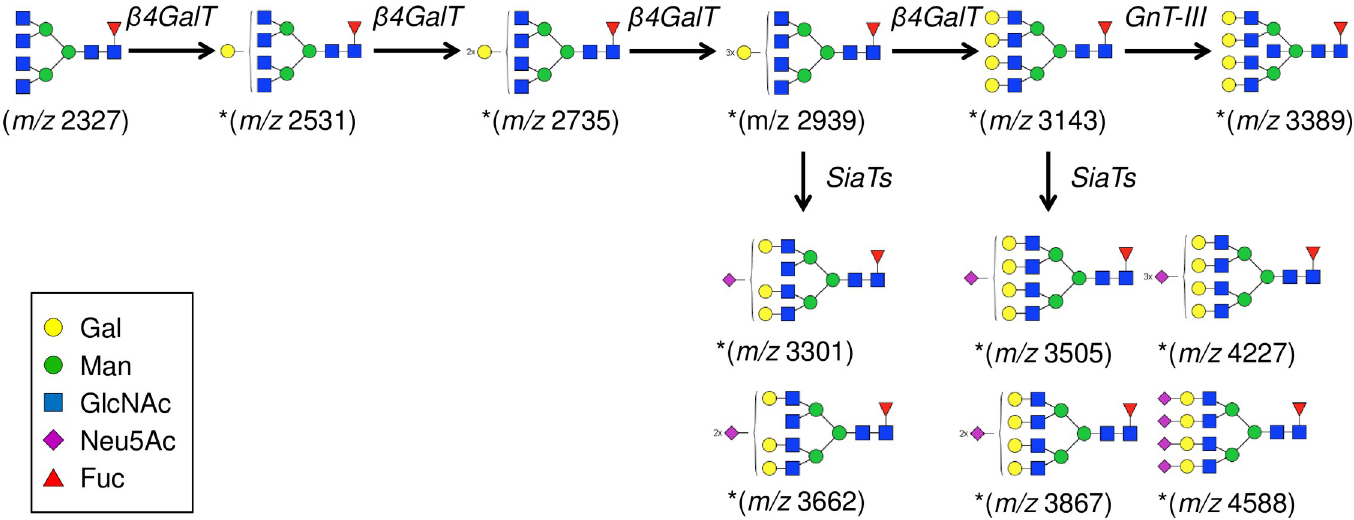
Fig 5. Biosynthetic pathways of tetra-antennary N -glycans. β 4GalT, beta-1,4-galactosyltransferase; SiaTs, Sialyltransferases.